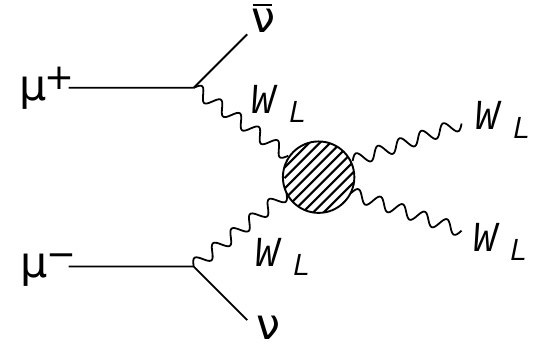
FIG. 12. Symbolic diagram for strong WW